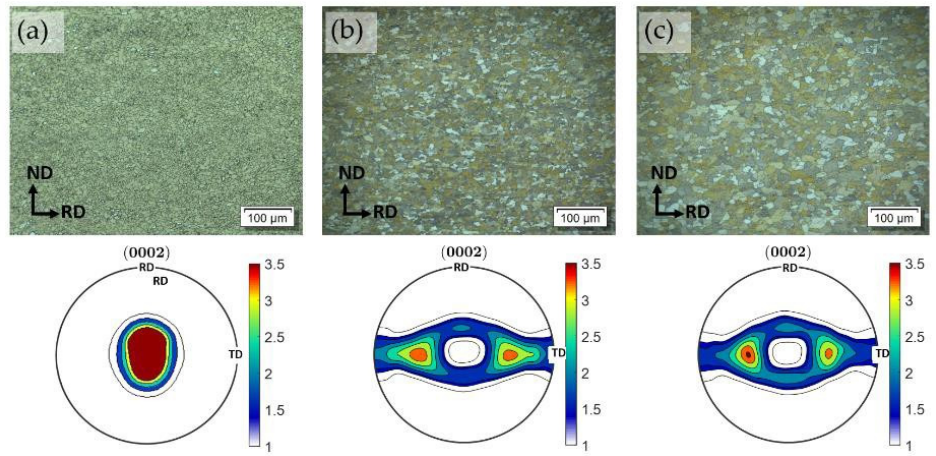
Figure 2. Microstructures and textures in terms of the (0001) pole figure of the: ( a ) AZ31 alloy, ( b ) Mg-RE1 alloy and ( c ) Mg-RE2